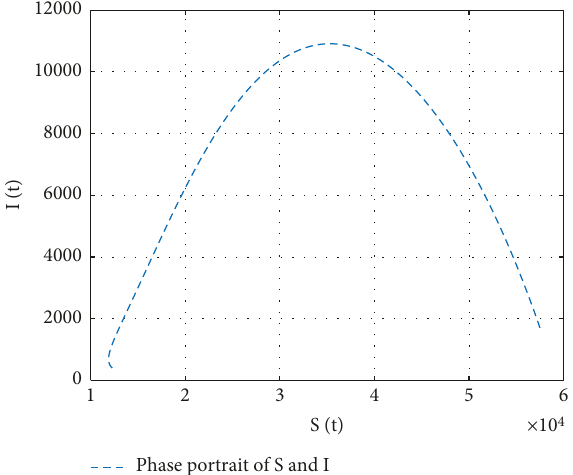
Figure 12: Simulation of the phase portrait of S(t) versus I(t)